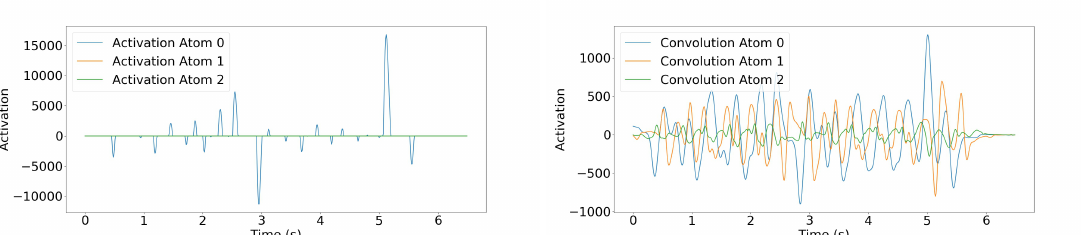
Figure 5. ( Left ) Convolutional sparse decomposition of the signal of Figure 3. Note that for this individual, only Atom 0 is used. ( Right ) Convolution of the same signal with each atom. For this signal, only Atom 0 was used in the sparse coding solution, but this differs in other signals. Moreover, it is interesting to note that since Atom 0 is mildly similar to a Gaussian kernel, the result of the convolution of the signal with Atom 0 is close to a smoothed version of the original